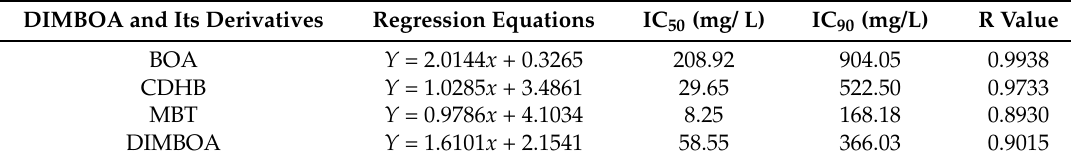
Table 3. IC 50 and IC 90 for DIMBOA and its derivatives against R. solanacearum.